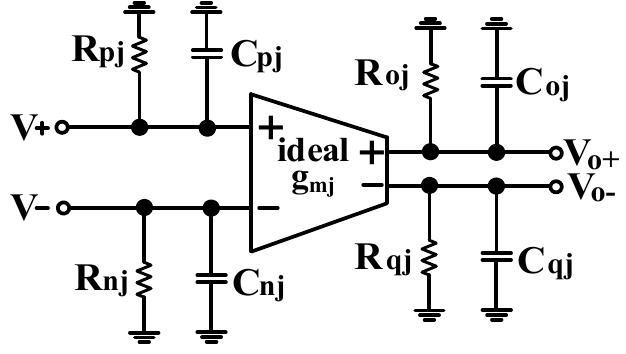
Figure 5. The non-ideal DO-OTA model.